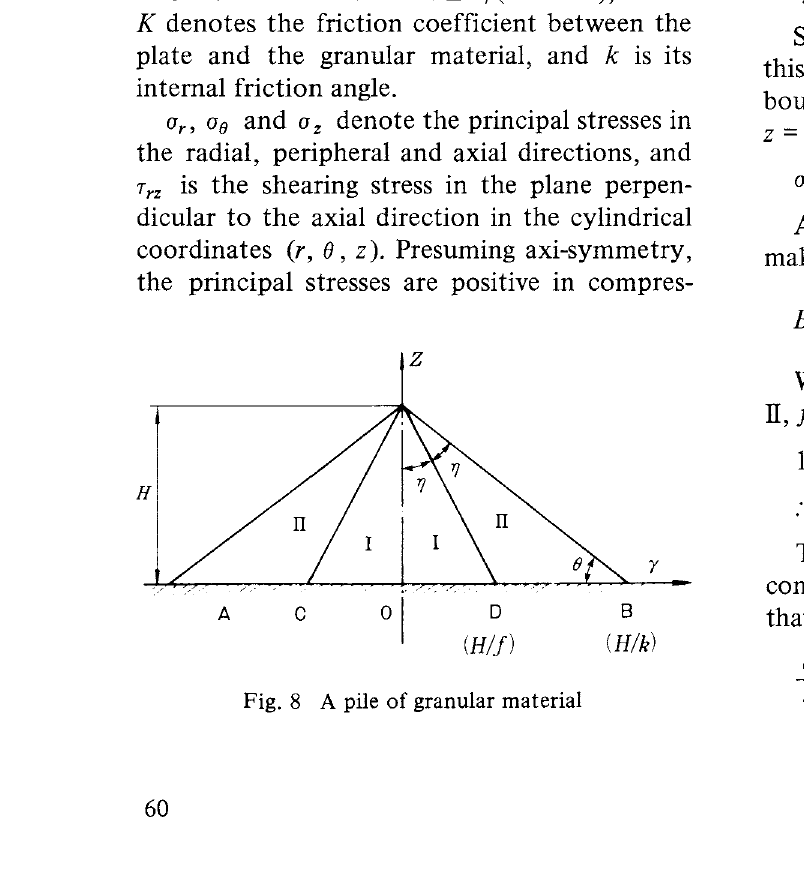
Fig. 8 A pile of granular